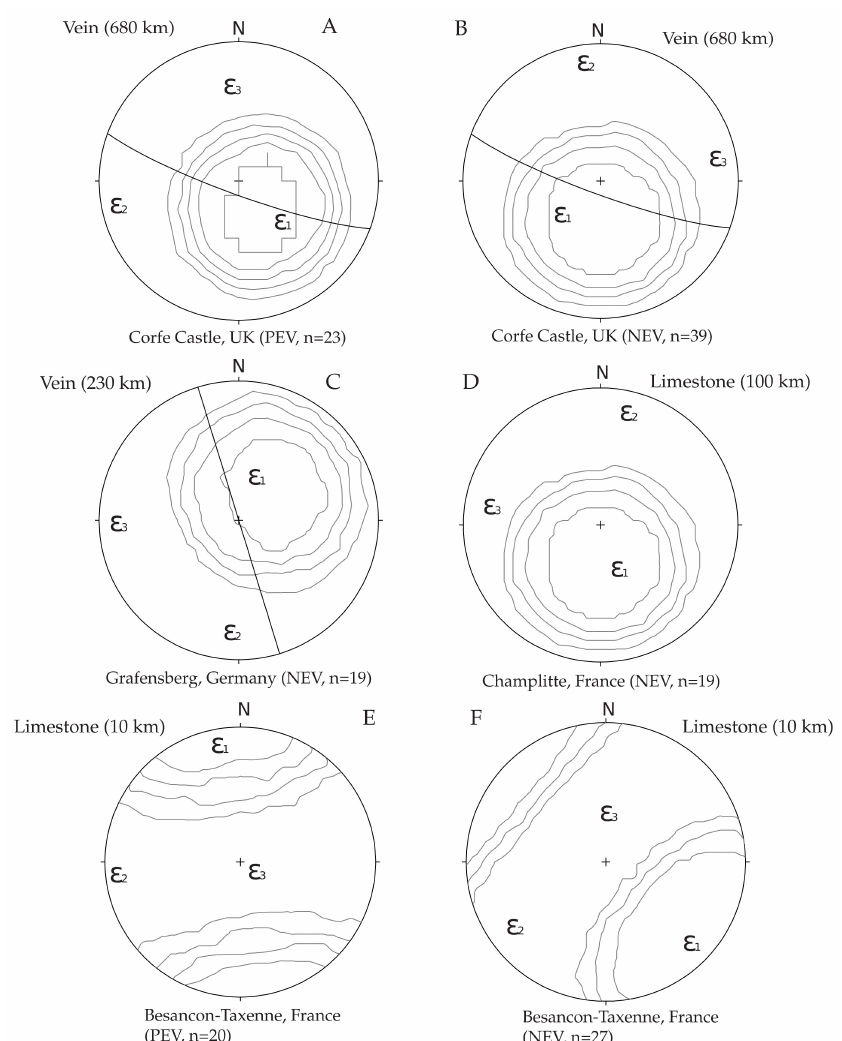
Figure 11. Stereoplots of calcite strain overprint (NEV) data that do not plot within the SE-NW plane of Alpine thrust transport and shortening ( A – D ) or of a twinning strain that does (( E , F ); see Figure 1, Table 2). Key: e1 = shortening strain axis, e2 = intermediate axis, e3 = extension axis with Turner (1953) compression axes contoured. Great circles are